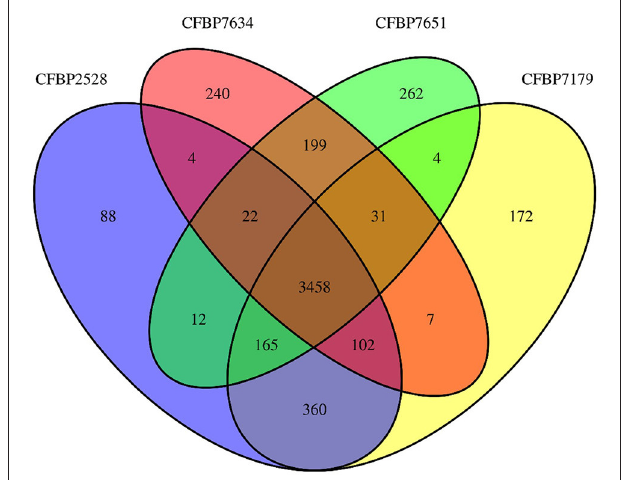
FIGURE 1 | Venn diagrams illustrating the comparisons of Xanthomonas arboricola